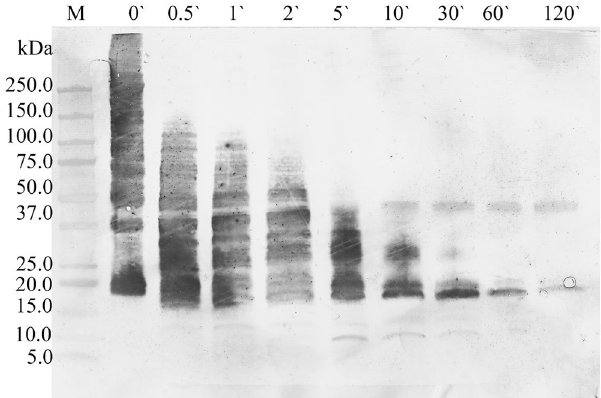
Figure 2. Anti- α -Gal-binding profile of gastric digestion of the bovine thyroglobulin under the physiological conditions with 0.2 U per µ g of pepsin. Numbers above each lane represent digestion time in minutes.